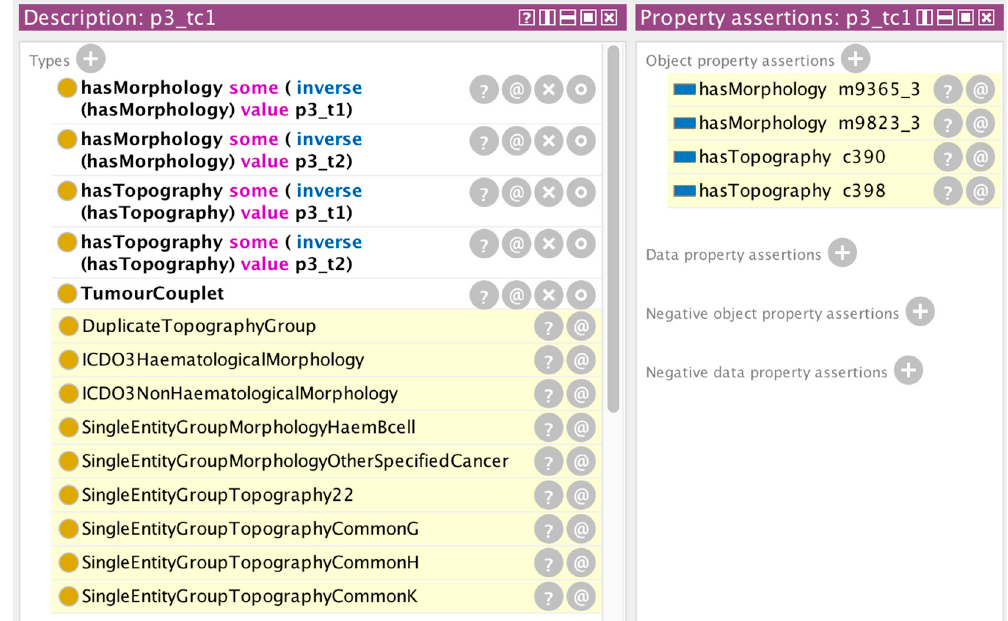
Figure 8. Results of the reasoning operation for the tumour couplet p3_tc1. Only topography codes are equivalent and therefore the couplet is a valid MPT.